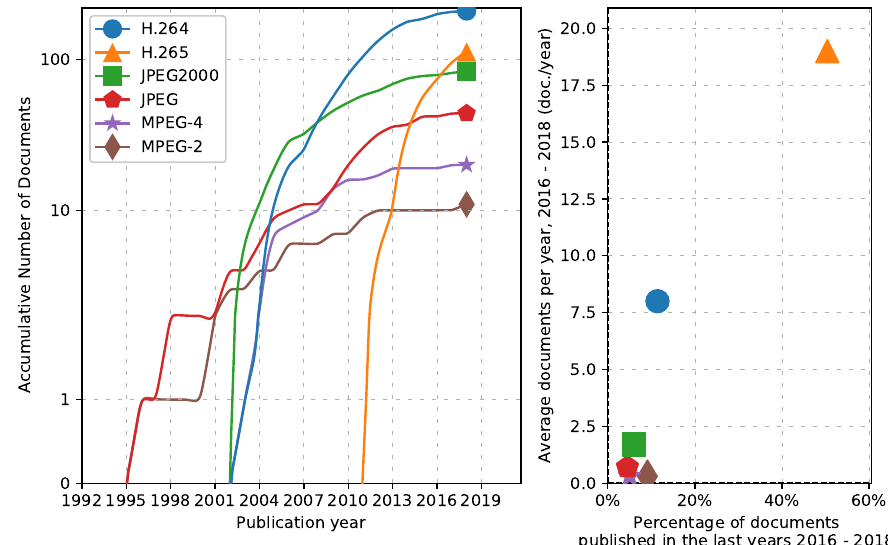
Figure 13. Image and video compressing codecs top implementations in FPGA